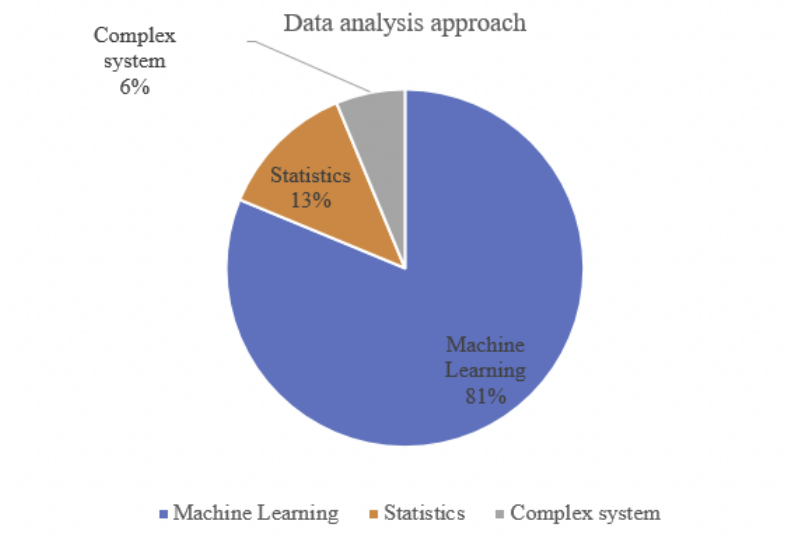
Figure 4. The ratio of Machine learning and Statistical approaches.